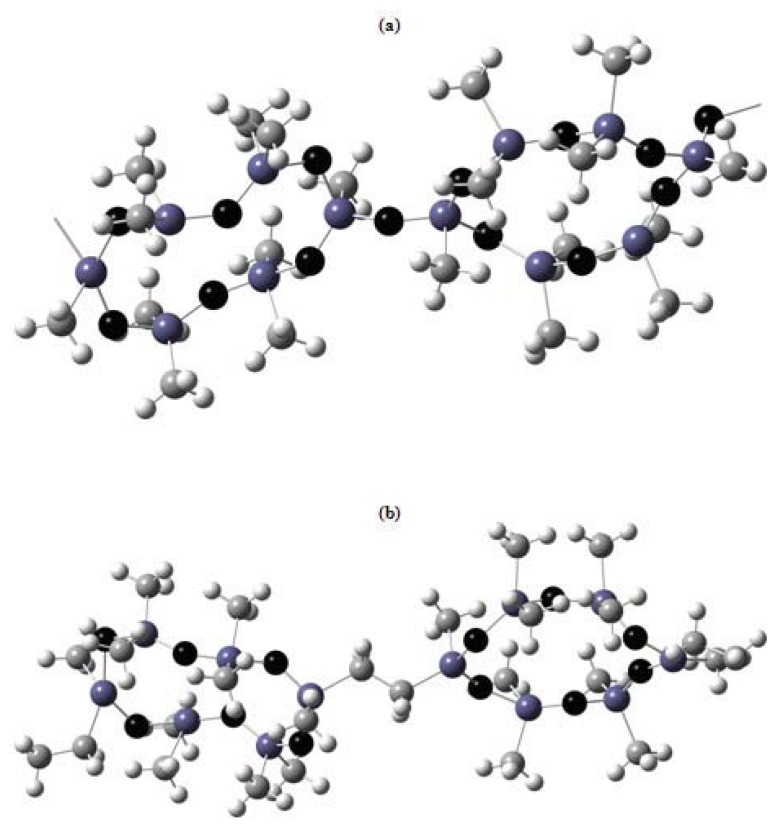
The most probable structure of monomer units in (a) CL PMS II-Me; and (b) CL PMCS IV-Me plotted using the Hyper Chem 5 software.